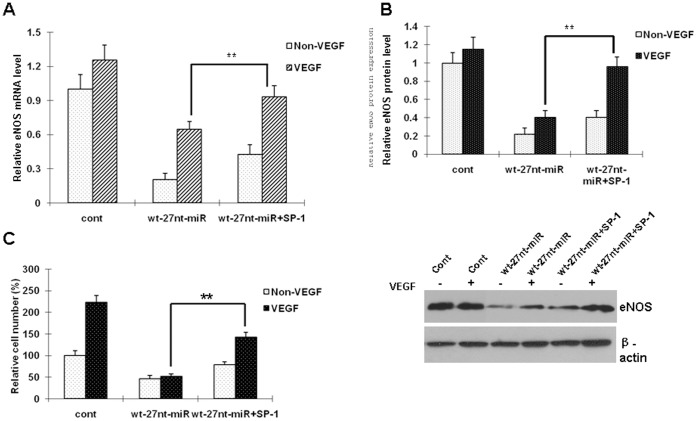
miRNA-reduced endothelial cell proliferation and eNOS expression are rescued by transient SP-1 expression.The cellswere transfected with 27nt miRNA alone or together with the SP-1 plasmid. The eNOS mRNA and protein, as well as the cell proliferation were analyzed. cont, cells transfected with control plasmid; wt-27nt-miR: cells transfected with plasmid of wild-ytpe 27-nt-miRNA; wt-27nt-miR+Sp-1: cells co-transfected with plasmids of wild-ytpe 27-nt-miRNA and SP-1. **, P<0.01 vs wt-27nt-miR alone (n = 3).